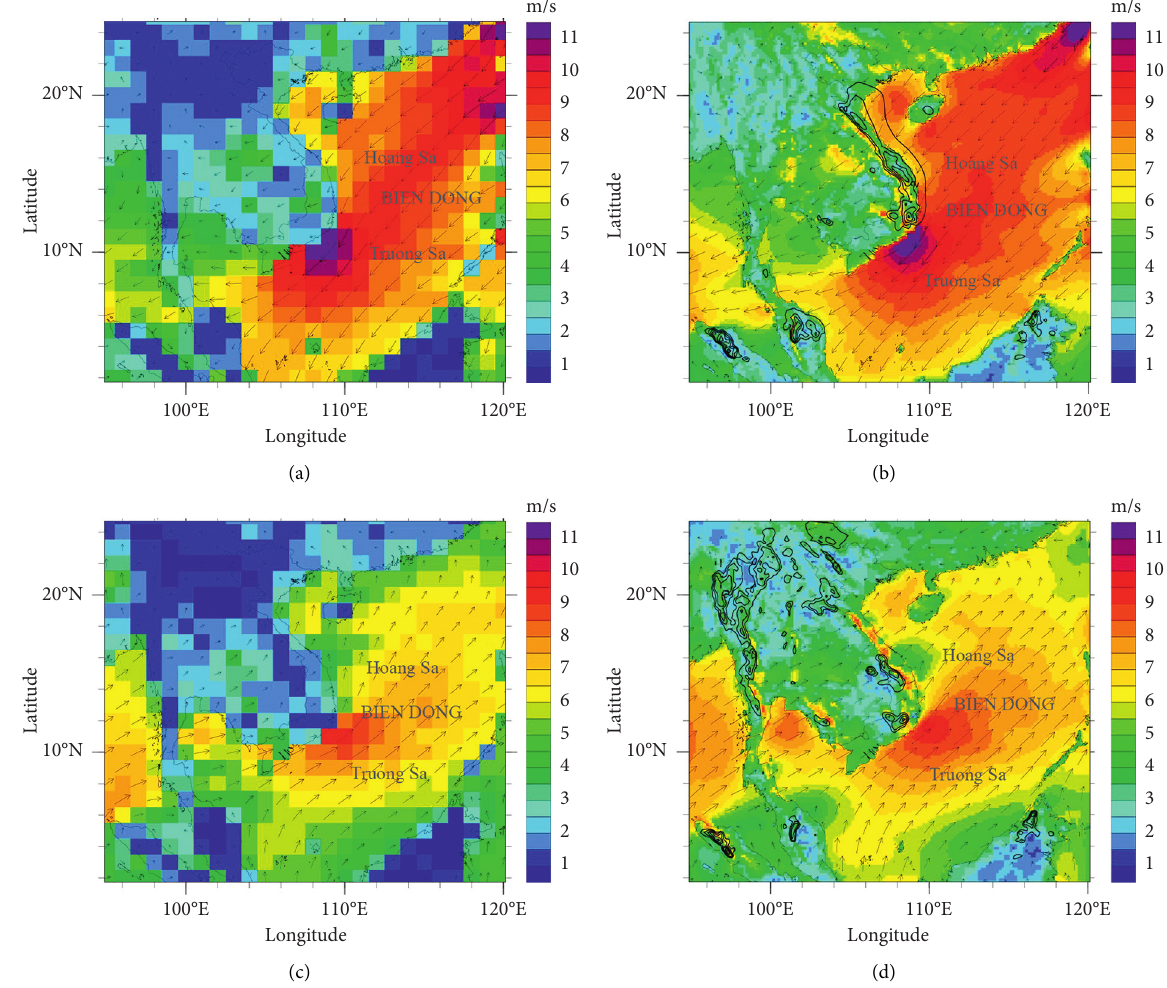
Figure 12: Mean wind speed at 10m height from FNL analysis data for Feb (a) and Aug (b) and WRF model at 18km resolution for Feb (c) and Aug (d). The contours on the WRF simulation are SLP anomalies (hPa) from the open ocean SLP at 115